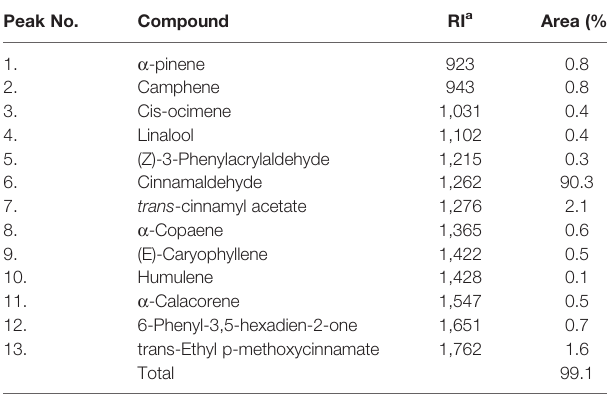
TABLE 2 | Chemical composition of C. zeylanicum methanolic extract determined by GC/MS. Peak